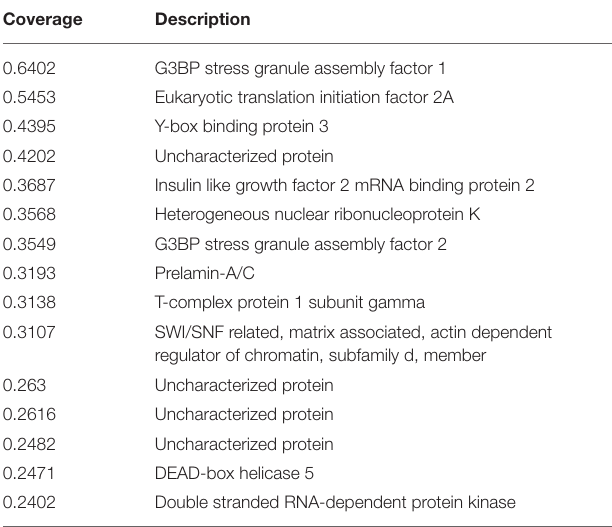
TABLE 2 | Identified proteins from immunoprecipitation reaction of